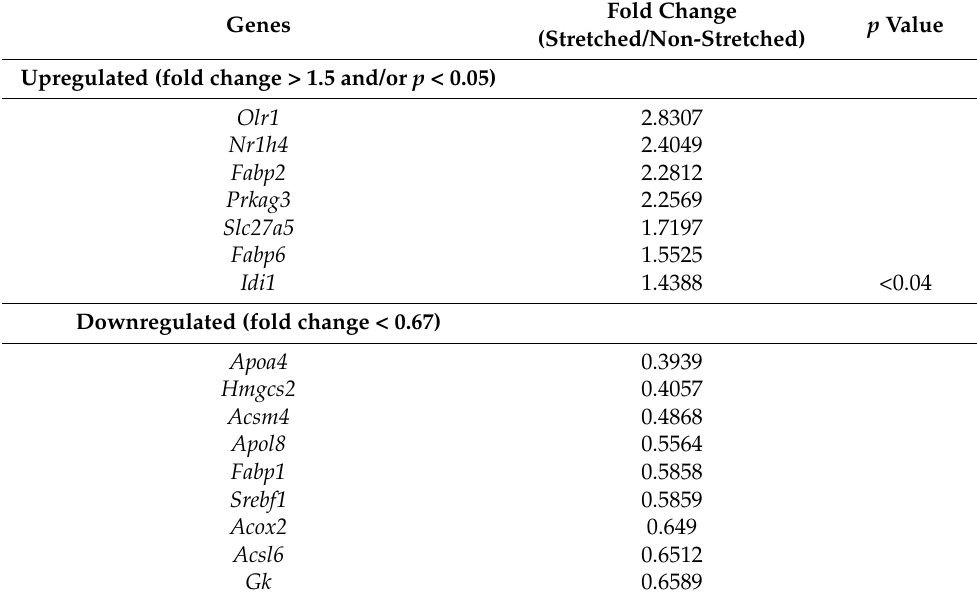
Table 1. Selected gene expressions revealed by PCR assay for fatty acid metabolism, lipoprotein signaling, and cholesterol metabolism: Comparison of stretched and non-stretched HL-1 atrial myocytes. Genes Fold Change (Stretched/Non-Stretched) p value Upregulated (fold change > 1.5 and/or p < 0.05) Olr1 2.8307 Nr1h4